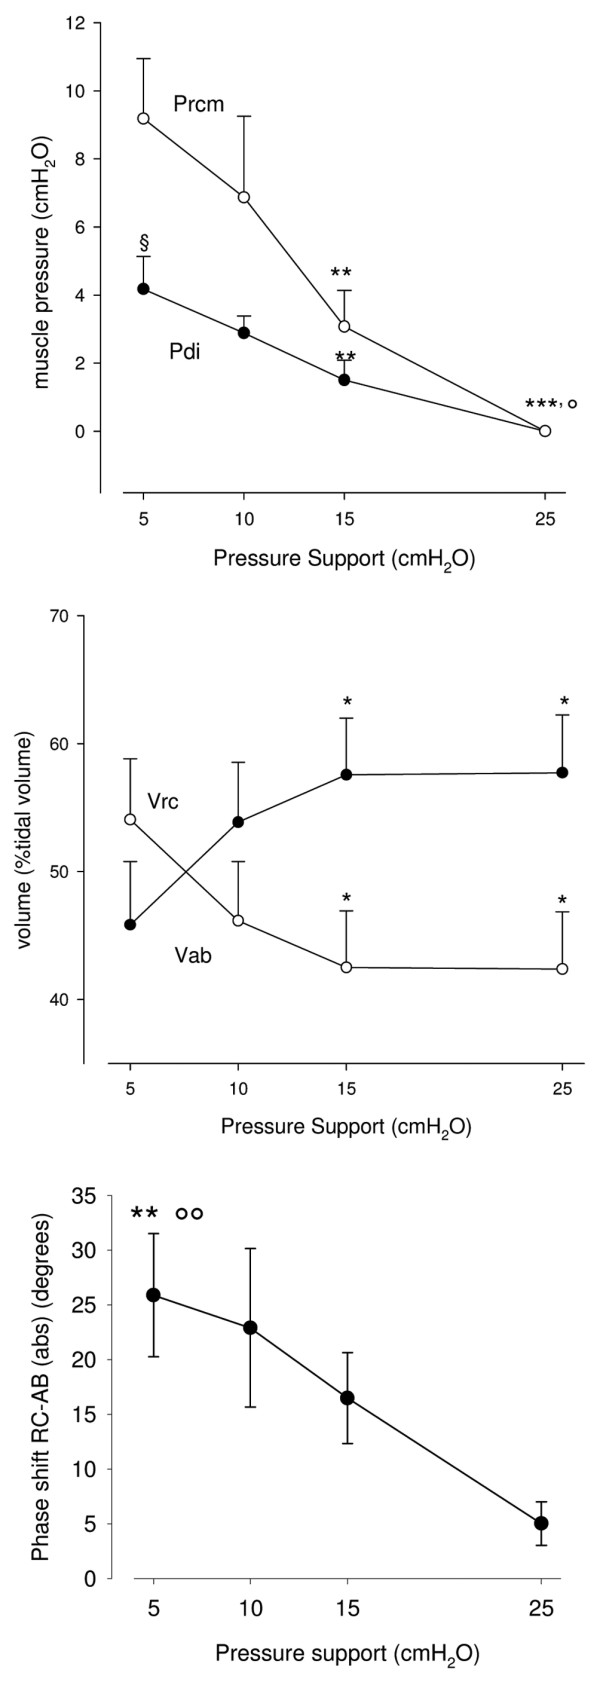
Relationship between pressure support level and muscle pressure, chest wall volume distribution and synchronization. (a) Mean ± standard error of the mean (SEM) values of transdiaphragmatic pressure (Pdi; closed symbols) and rib cage muscle pressure (Prcm; open symbols) at different levels of pressure support. **P < 0.01,***P < 0.001, versus pressure support at 5 cmH2O. °P < 0.01, versus pressure support at 10 cmH2O. P < 0.05, versus Prcm. (b) Mean ± SEM values of percentage contribution to tidal volume of abdomen (Vab; closed symbols) and rib cage (Vrc; open symbols) at different levels of pressure support. *P < 0.05, versus Pressure support at 5 cmH2O. (c) Mean ± SEM values of absolute values of phase shift between rib cage (RC) and abdomen (AB) at different levels of pressure support. **P < 0.01, versus pressure support at 25 cmH2O. °°P < 0.01 versus pressure support at 15 cmH2O.